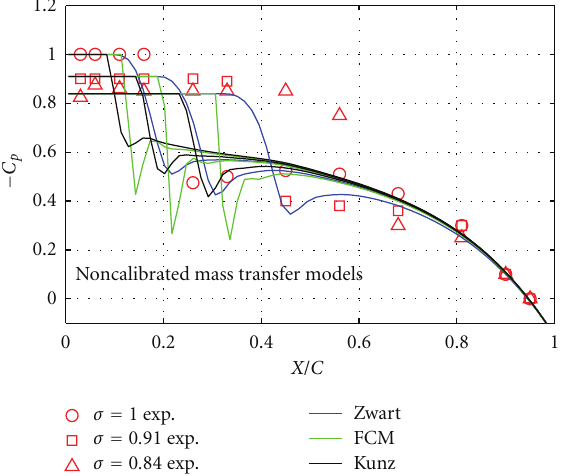
Figure 6: NACA66(MOD) hydrofoil at AoA = 4 o , Re = 2 × 10 6 . Suction side pressure distributions computed using calibrated Zwart, FCM, and Kunz mass transfer